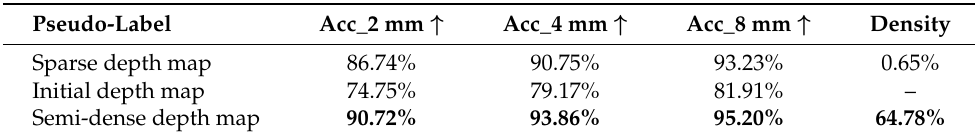
Table 5. Evaluation of different pseudo-labels. The best results are in bold.